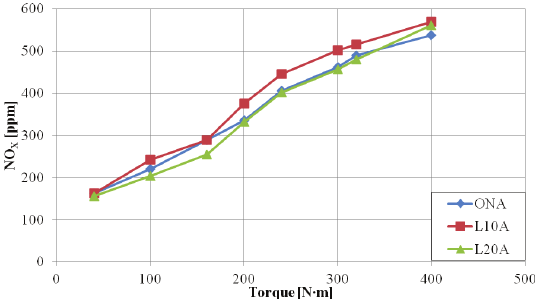
Fig. 2. NO x concentration for injection timing A and n = 1400 rpm